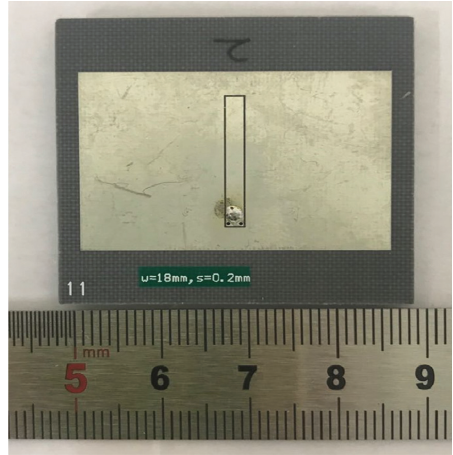
Figure 5: Photograph of the fabricated MA.